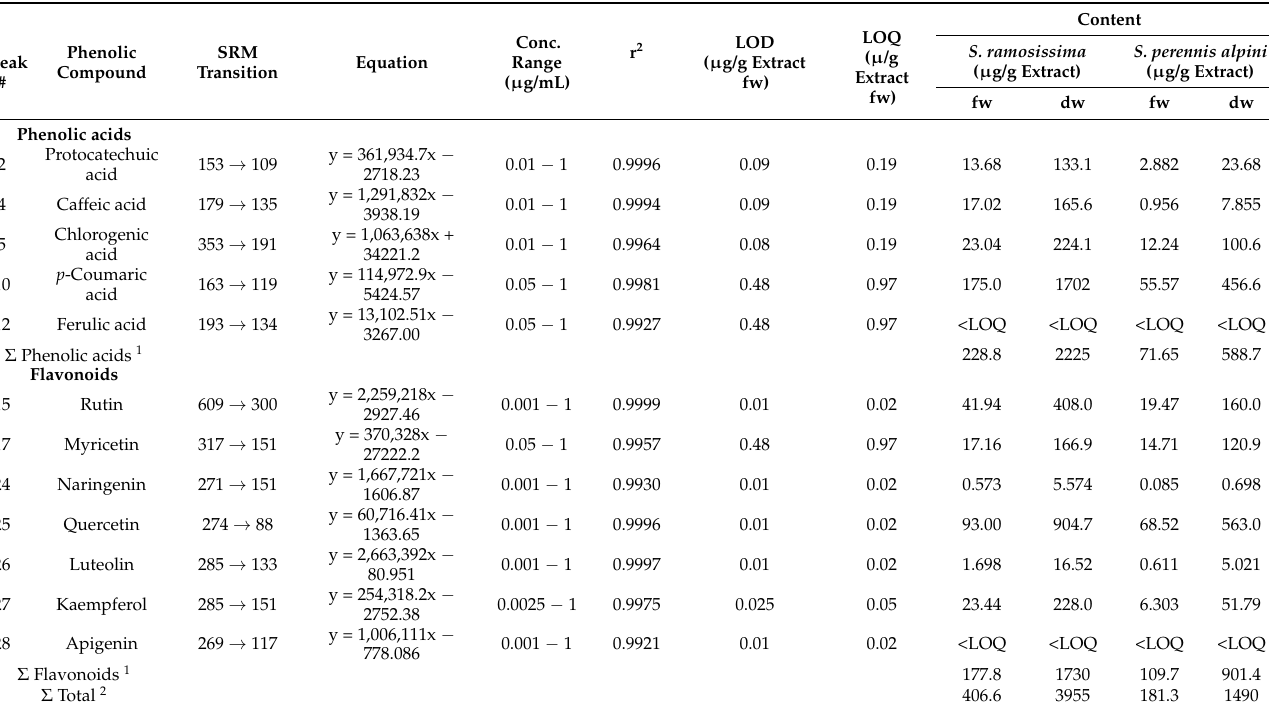
Table 5. Detected parameters: SRM, linearity, LOD, and LOQ; and individual and total amounts of the main phenolic compounds ( µ g/g extract) quantified in Salicornia ramosissima and Sarcocornia perennis alpini .